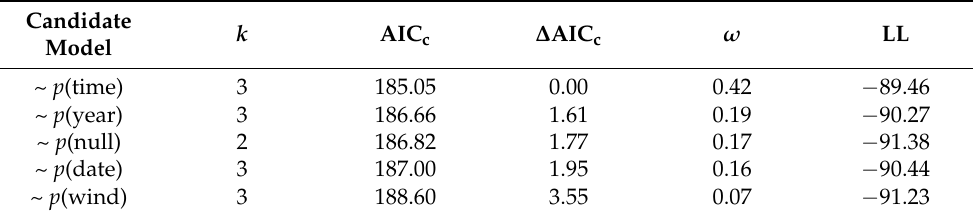
Table A1. Model selection based on the AIC c for the estimation of detection probability ( p ) of American Three-toed Woodpecker in managed boreal forest in eastern Canada. The number of parameters ( k ), second-order Akaike’s information criterion (AIC c ), ∆ AIC c , Akaike weights ( ω ), log-likelihood (LL) are included in the table and occupancy ( ψ ) is held constant for each candidate